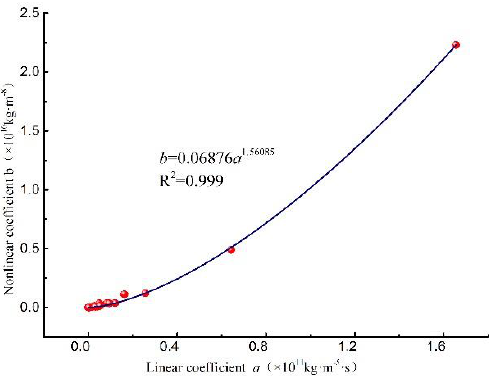
Figure 7. Relationship between nonlinear coefficient b and linear coefficient a.